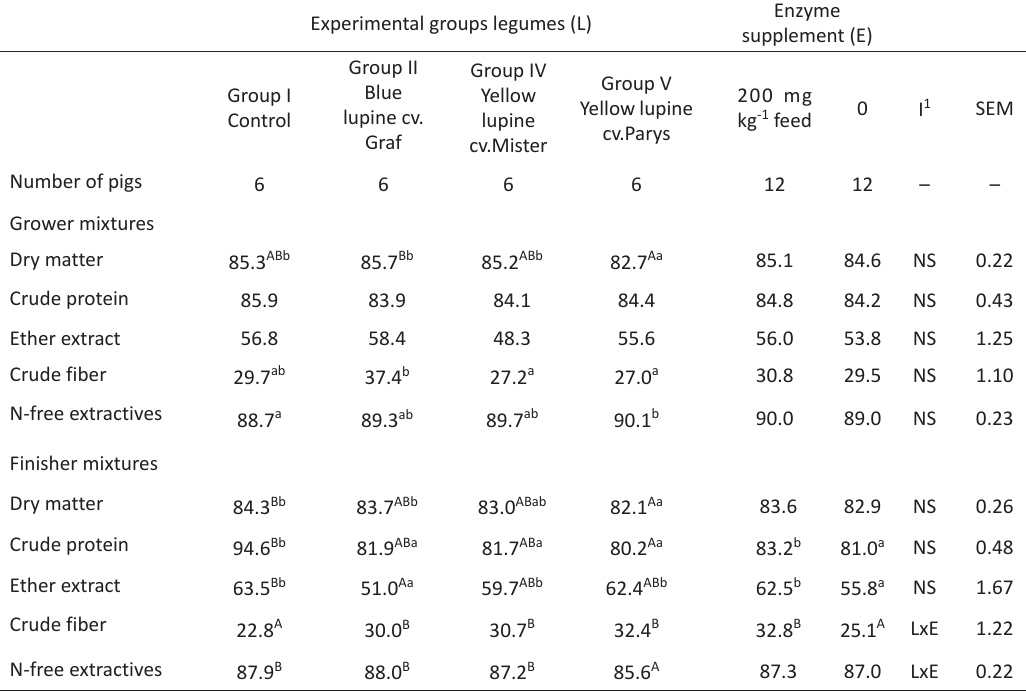
Table 10. Apparent digestibility coefficients of grower and finisher feed